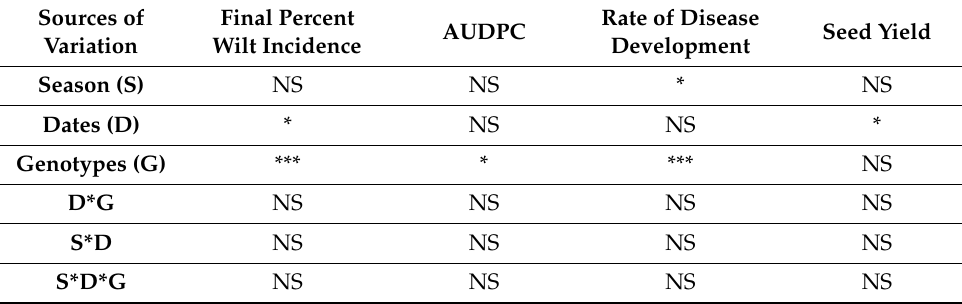
Table 2. Analysis of variance for three disease parameters and seed yield of